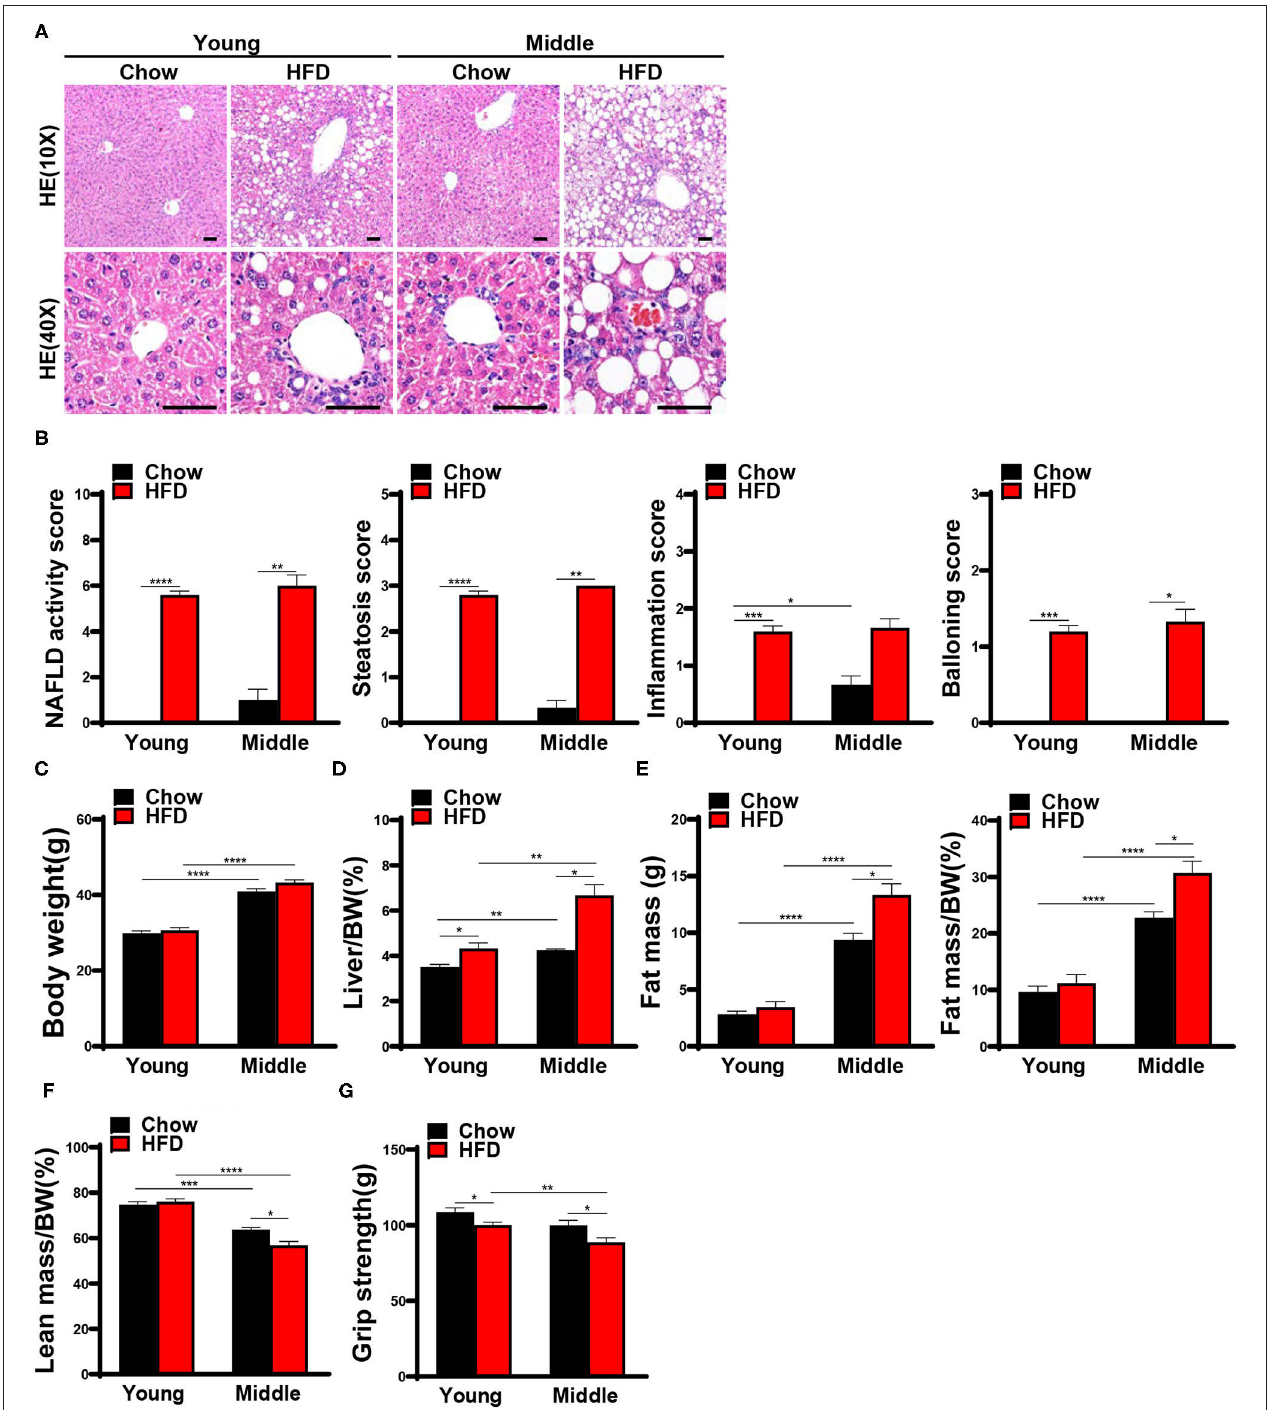
FIGURE 1 | Twelve weeks HFD feeding induced steatohepatitis and decreased muscle strength in mice. 8-week-old and 42-week-old male C57BL/6 mice were fed with a high-fat diet (HFD) for 12 weeks, mice were sacrificed after the assessment of body composition and muscle strength, and liver and muscle tissues were harvested. (A) Representative hematoxylin and eosin staining of mice liver and (B) NAFLD activity score ( n = 3–5) are shown (scale bar, 50 µ m). (C) Body weights and (D) Liver indexes were assessed in mice ( n = 3–5). Body composition was measured by nuclear magnetic resonance (NMR), (E) Fat mass, Fat mass/bodyweight (BW), (F) Lean mass/BW are shown ( n = 3–5). (G) Forelimb grip strength are detected ( n = 8–29). The data are presented as the mean ± SEM, unpaired two-tailed Student’s t -test. * P < 0.05, ** P < 0.01, *** P < 0.001, **** P <